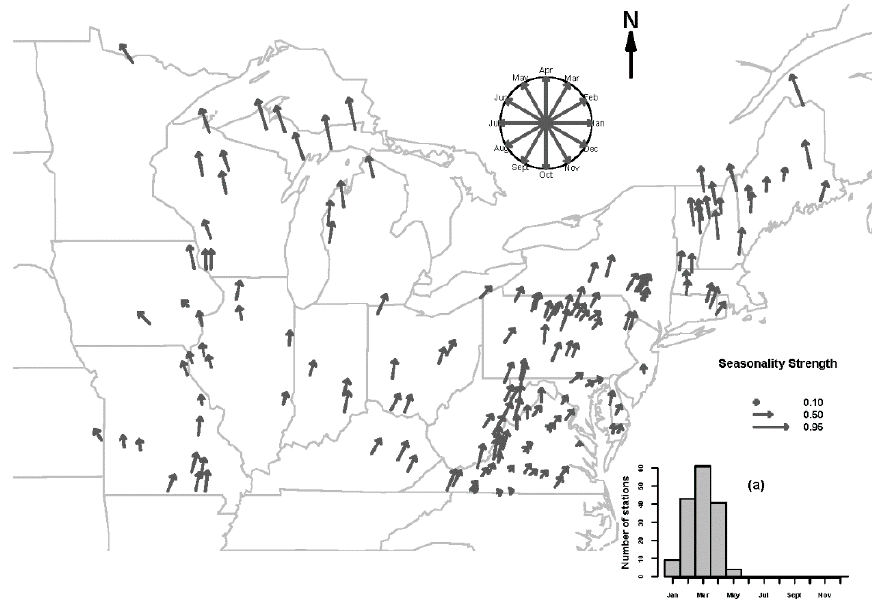
Figure 2. Spatial patterns of seasonality of daily annual maximum streamflow for the period 1951–2010 ( n = 60) based on circular mean ( θ ) and variability ( ρ ); ( a ) the frequency of stations with similar mean streamflow seasonality. Here the direction of arrows indicates the mean and the length of arrows indicate the strength of seasonality.